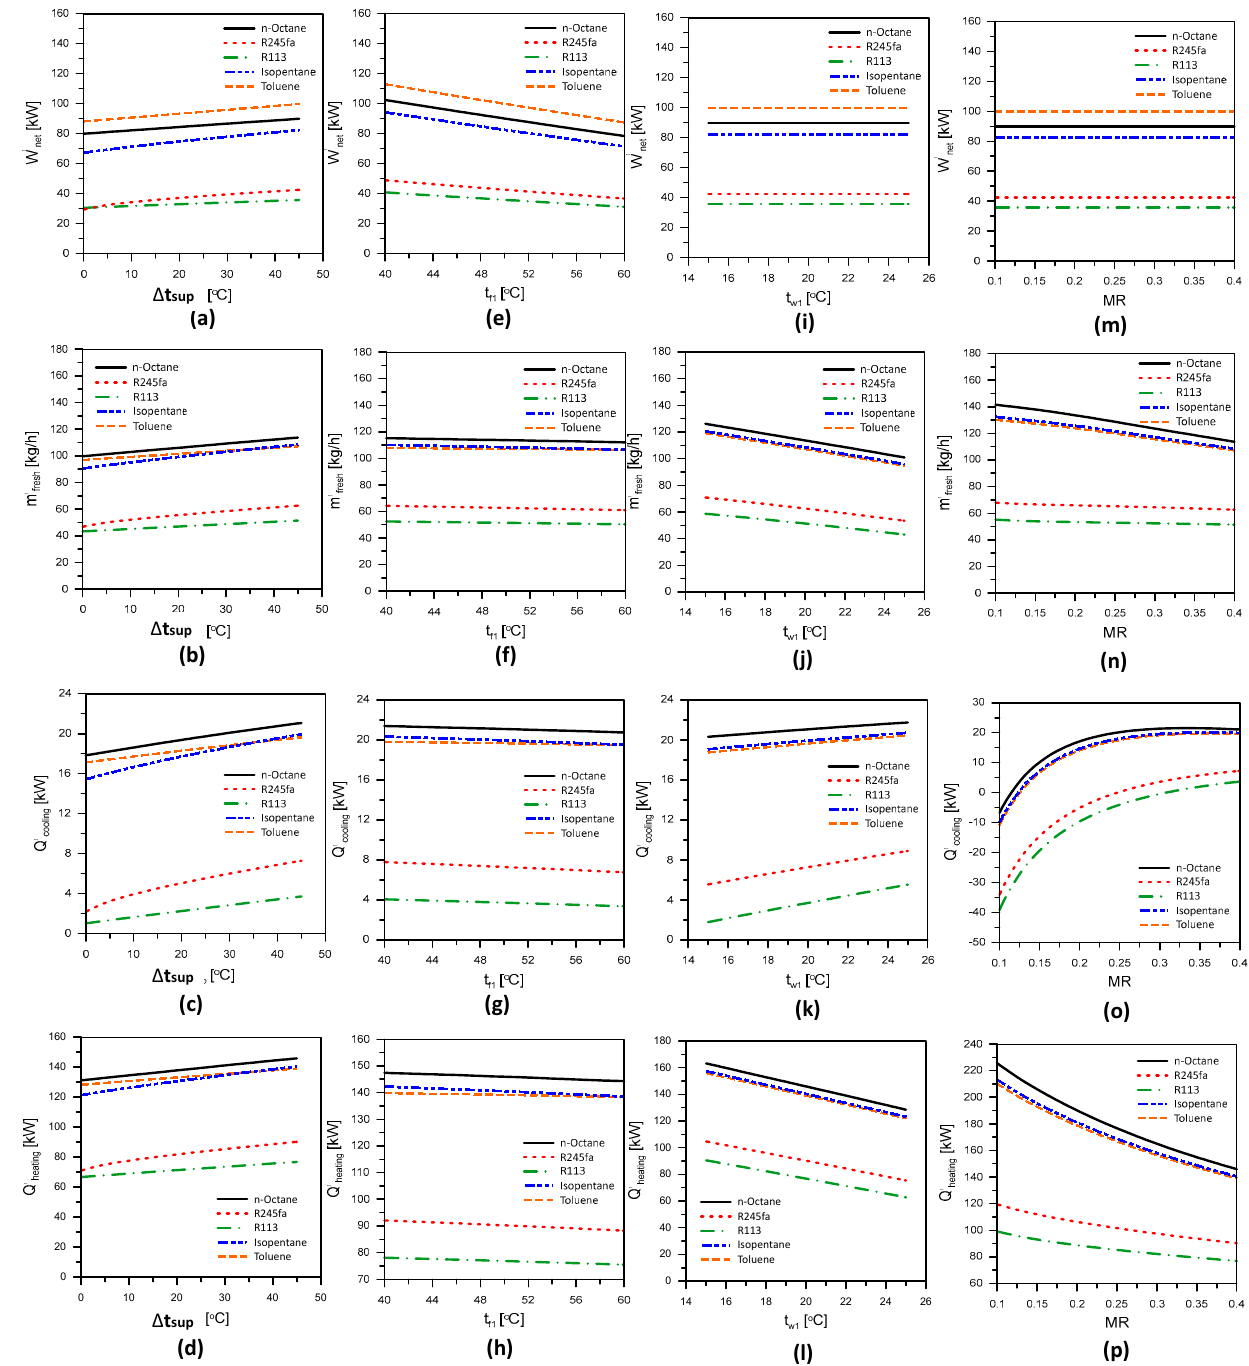
Figure 4. Variations of the systems’ productivity with various studied parameters: ( a – d ) ∆ t sup ; ( e – h ) t f1 ; ( i – l ) t w1 ; ( m – p ) MR.